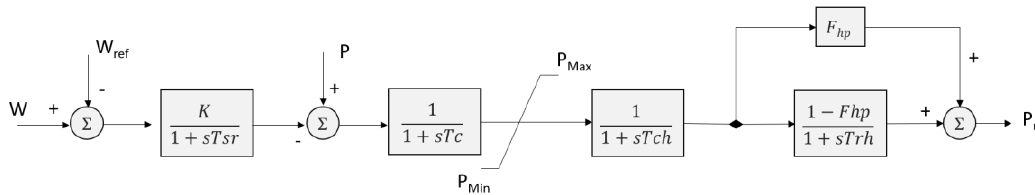
Figure A5. Steam turbine governor (adopted by [58]).